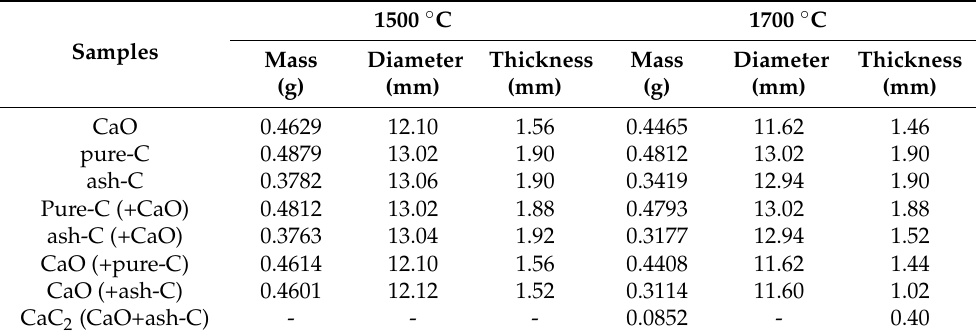
Table 3. Mass and size of samples after the heat